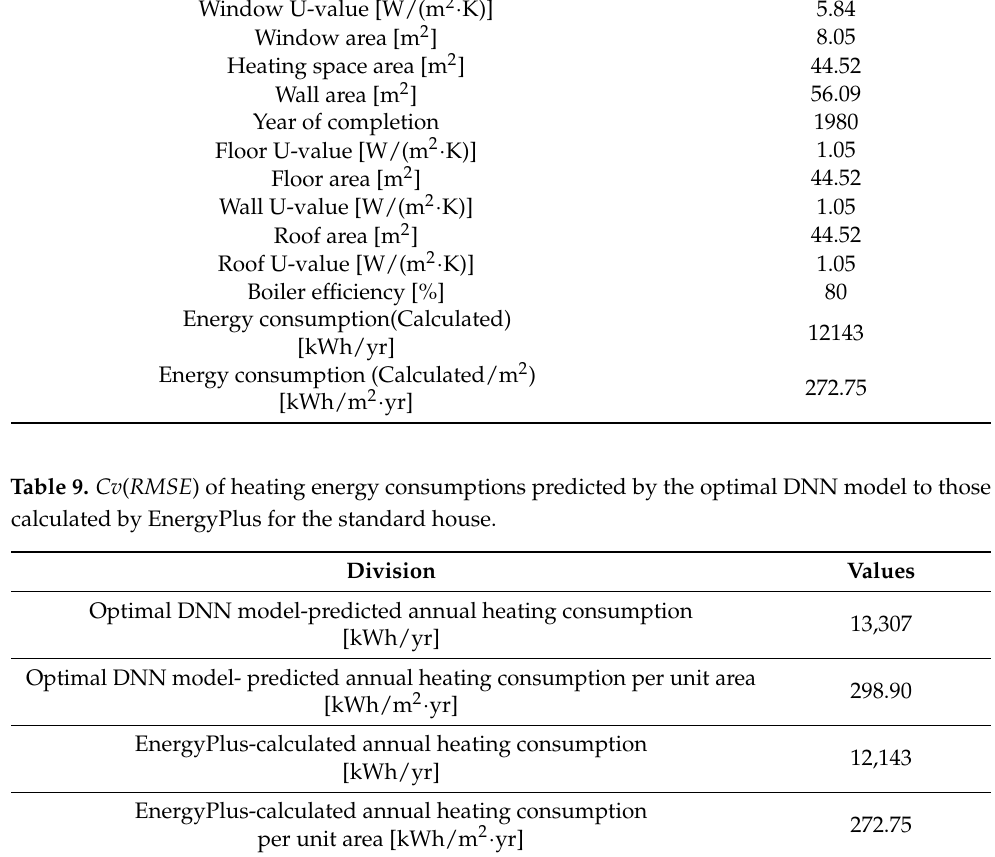
Table 10. ASHRAE guideline of tolerance limits for the Cv ( RMSE ) of building energy modelling.